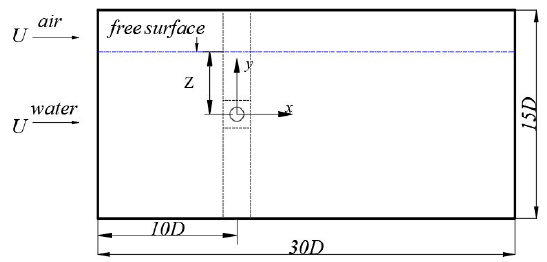
Figure 1. Computational domain.